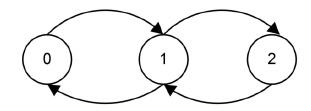
Figure 1. State transition